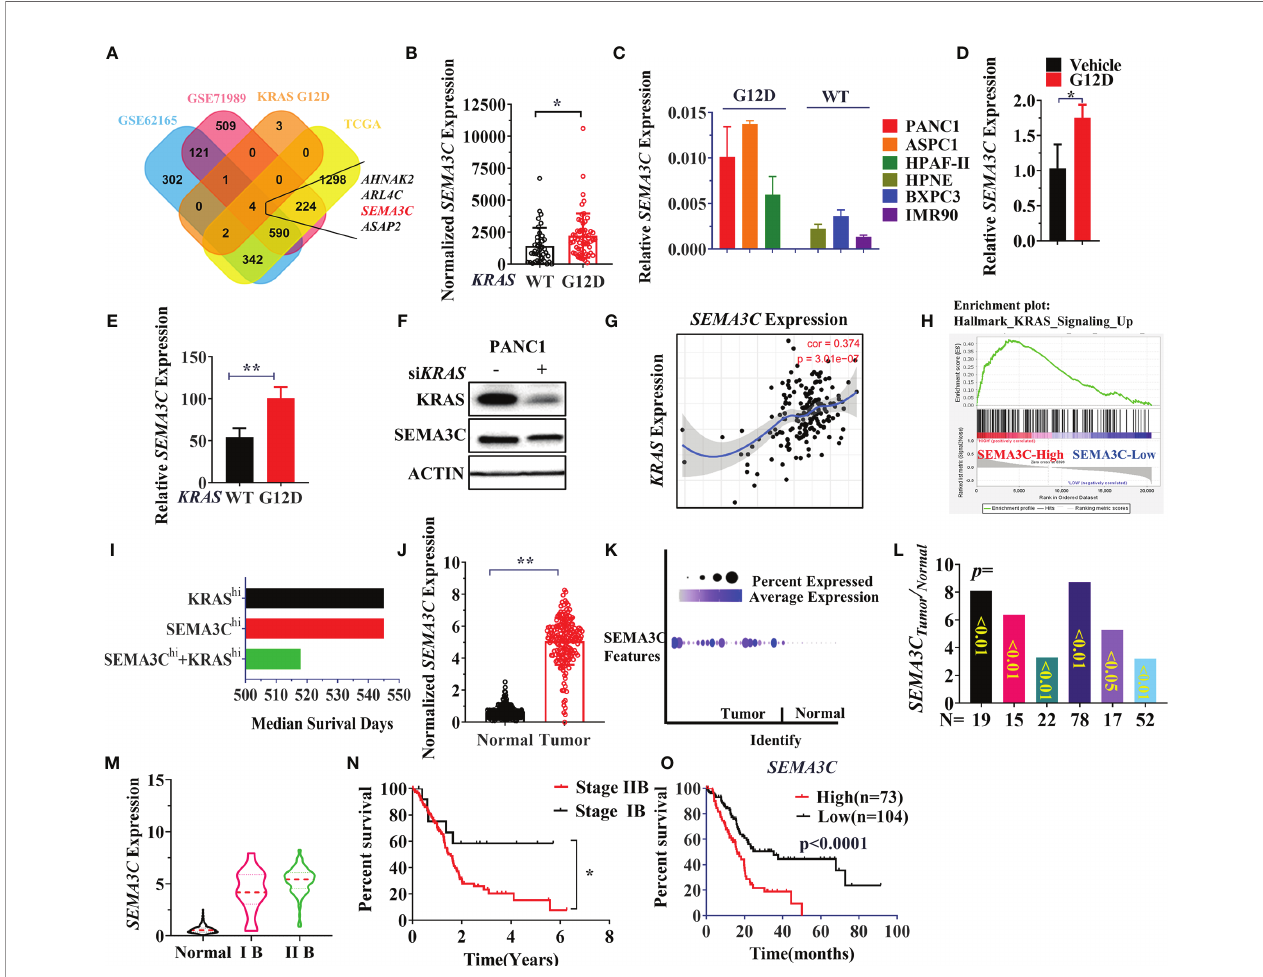
FIGURE 2 | (A) Simultaneous highly expressed genes in KRAS G12D mutation patients/cells, TCGA and GEO datasets (GSE62125/GSE71989). The normalized gene expression data were used for the comparison of two groups, the FC (fold change)>=1.5, p-Value<=0.05. (B) SEMA3C expression in KRAS WT and G12D mutation patients from TCGA data. (C) SEMA3C expression in cell lines with or without KRAS G12D mutation evaluated by the qPCR assay (KRAS WT cell lines: HPNE, BxPC3, IMR90; KRAS G12D cell lines: PANC1, ASPC1, HPAF-II). (D) SEMA3C expression was detected by qPCR after overexpression of the KRAS G12D for 48 hours. (E) SEMA3C expression in KPC cell lines with or without KRAS G12D mutation, data was collected in the GSE63348 database. (F) SEMA3C protein expression after depletion of KRAS in PANC1 cells. (G) The correlation between KRAS and SEMA3C expression analyzed by Timer software (H) High expressed or low expressed of SEMA3C enriched signaling pathway by the GSEA analysis. (I) Survival analysis of the patient group with high expression of SEMA3C, KRAS and both high expressions by the PROGgeneV2. (J) The expression data are fi rst log2(TPM+1) transformed for differential analysis and the log2FC is de fi ned as median (Tumor) and median (TCGA normal + GTEx normal), data were collected and analyzed by GEPIA. (K) The expression analysis of the SEMA3C from GSA: CRA001160 data (40). (L) SEMA3C expression data from the Oncomine in different groups (Segara; Logsdon; Grutzmann; Badea; Iacobuzio Donahue; Pei). ( M) SEMA3C expression analyzed in different clinical stages of pancreatic cancer from www.aclbi.com. (N) The overall survival of patients analyzed in different stages of pancreatic cancer. (O) The overall survival of the SEMA3C expression. Data from KM plot, signi fi cance vs. cutoff values between lower and upper quartiles of expression. Data are representative of three independent experiments. T-tests or log-rank Test for the measurements between the two groups; *P < 0.05, **P <